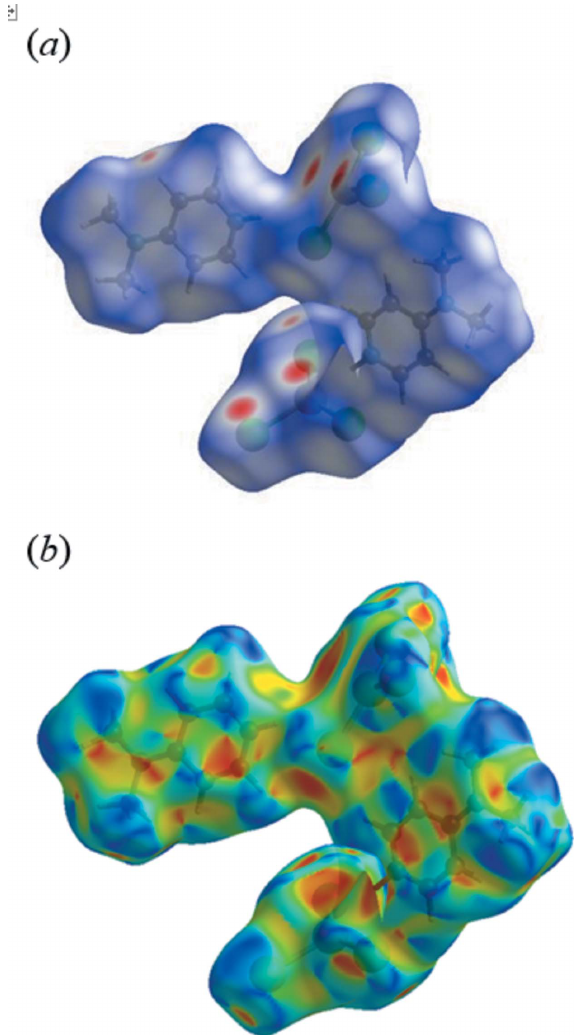
Figure 10 View of the Hirshfeld surfaces for (I) mapped over ( a ) d norm and ( b ) shape-index, displaying the intermolecular interactions.